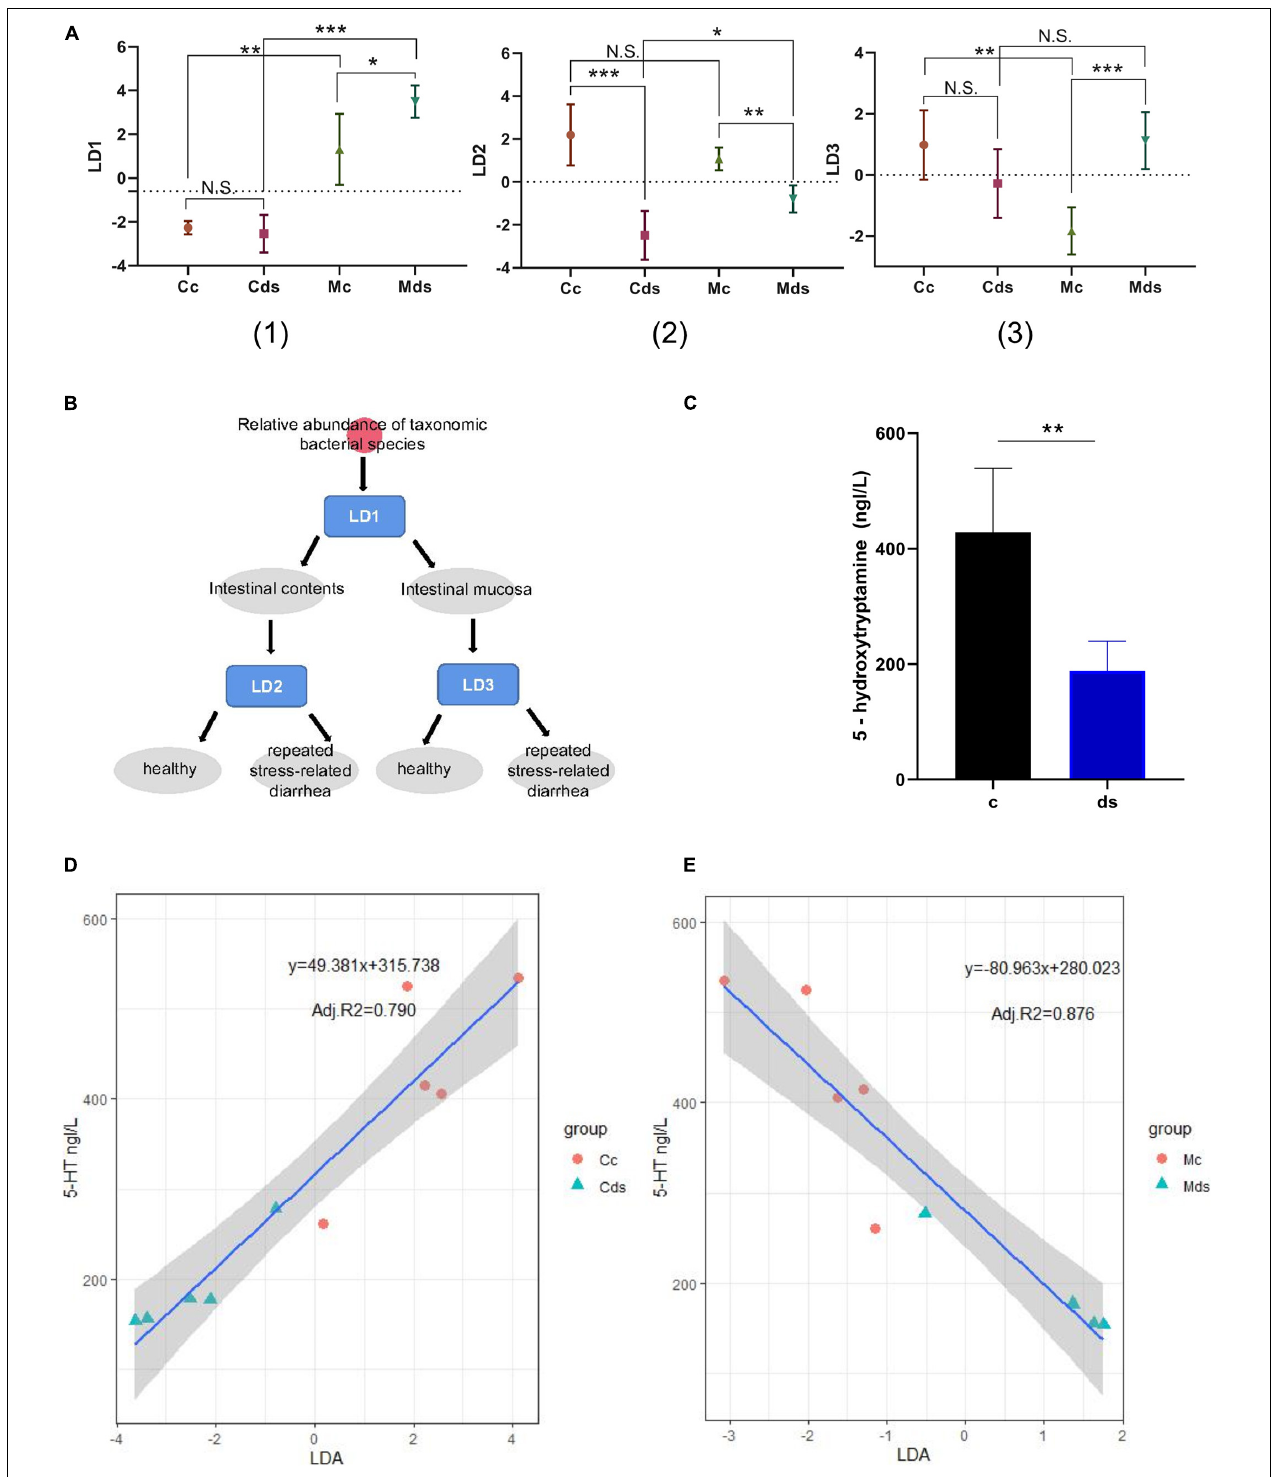
FIGURE 7 | Establishment of a prediction model of 5-HT concentration based on bacterial relative abundance. (A) Prediction and classification of samples by the relative abundance of microbiota-based machine-learning models LD1 (1), LD2 (2), and LD3 (3). (B) Schematic diagram of the bacterial relative abundance model discrimination. (C) Serum 5-HT concentration. (D) Correlation between serum 5-HT concentration and intestinal content microbiota. (E) Correlation between serum 5-HT concentration and intestinal mucosa microbiota. * P < 0.05, ** P < 0.01, *** P < 0.001; N.S., not significant ( P > 0.05). Cc, intestinal contents in control mice; Cds, intestinal contents in repeated stress-related diarrhea mice; Mc, intestinal mucosa in control mice; Mds, intestinal mucosa in repeated stress-related diarrhea mice.